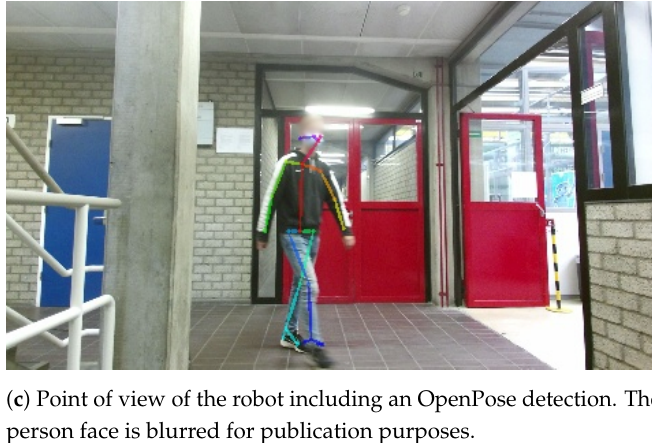
Figure 4. Visualization of the experiment-environment. The detection originates from [29].